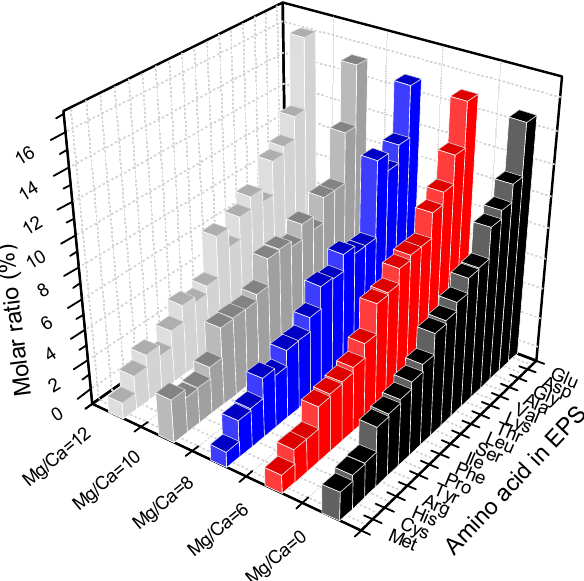
Figure 12. Amino acids in the EPS of SRB2 cells in different culture media with various Mg/Ca ratios.